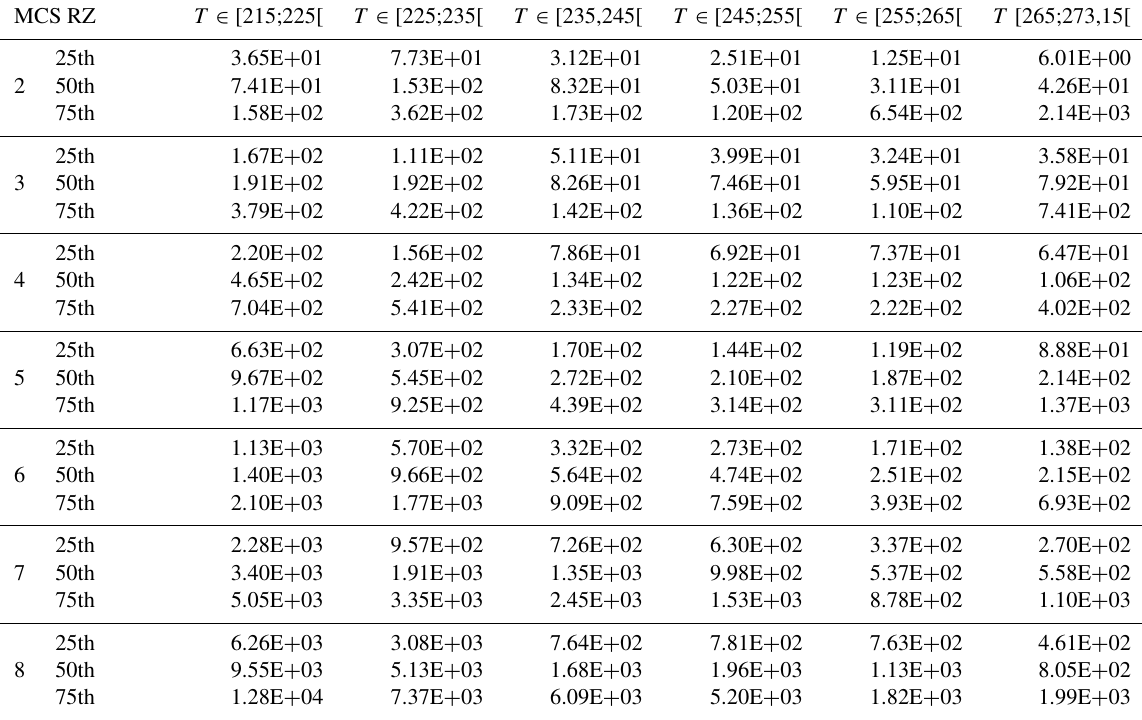
Table C4. Total concentration beyond 15µm ( N T ) in L − 1 (Fig. A1). MCS RZ